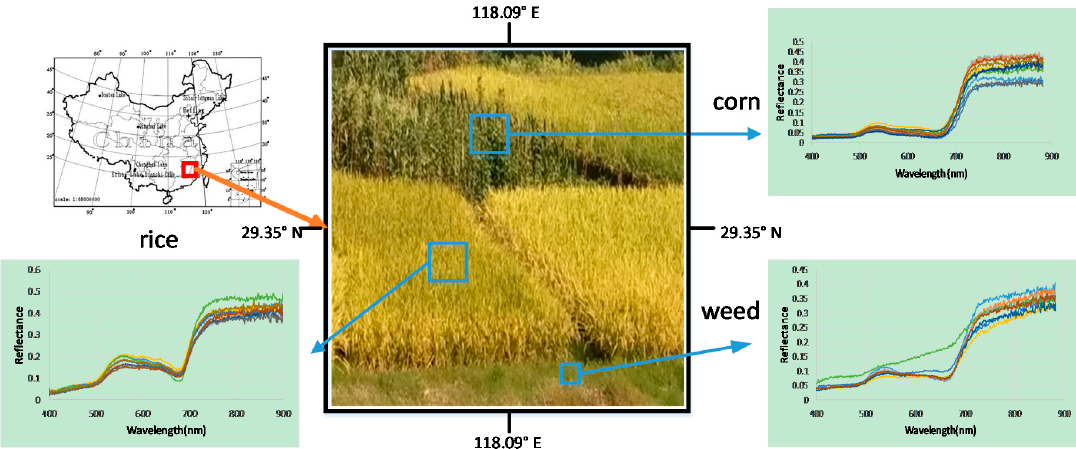
Figure 5. Illustration of the first study agricultural site near Wuyuan, Jiangxi Province, China. The site is dominated by the rice, corn, and weed.